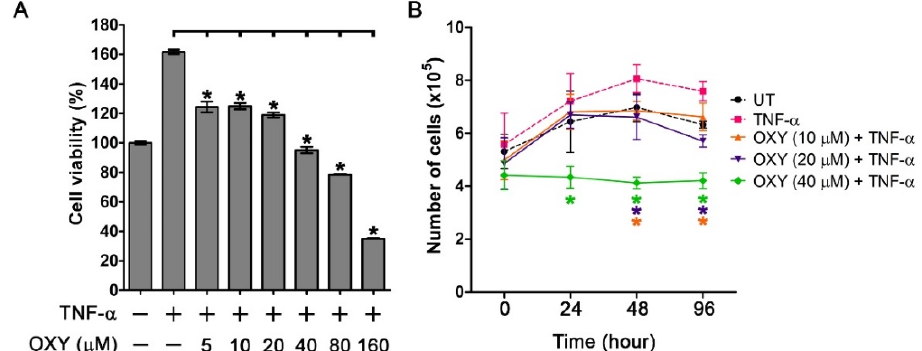
Figure 2. Effects of oxyresveratrol (OXY) on cell viability and proliferation of TNF- α -stimulated HaCaT cells. ( A ) Cell viability assay by MTT of HaCaT cells pre-treated with OXY (5, 10, 20, 40, 80, and 160 μ M) for 3 h and stimulated with 100 ng/mL of TNF- α for 48 h. ( B ) Cell counting assay for quantifying the number of TNF- α -stimulated HaCaT cells treated with different concentrations of OXY (10, 20, and 40 μ M) at various time points (0, 24, 48, and 96 h). * p < 0.05 in comparison to the TNF- α -treated group.